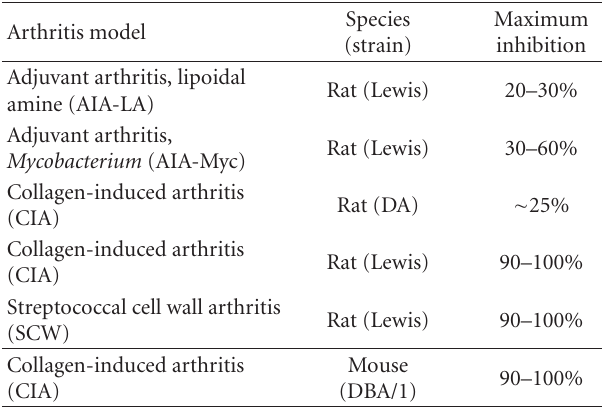
Table 3: Antiarthritic e ffi cacy varies among di ff erent rodent models of immune-mediated arthritis. Arthritis